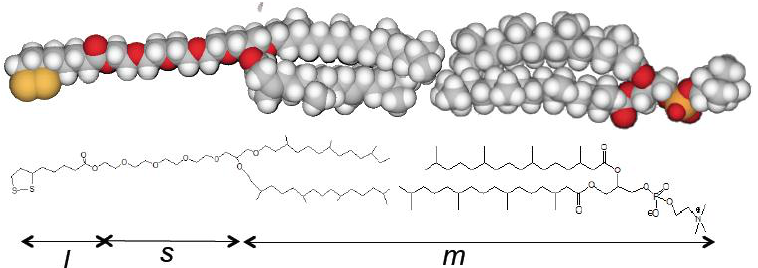
Figure 5. Space filling model and structure of the DPTL thiolipid lipid and of DPhPC, in a tail-to-tail configuration; l , s , and m denote the lipoic acid residue, the tetraethyleneoxy spacer and the hydrocarbon tail region, forming the monomeric unit of a DPTL/DPhPC tethered bilayer lipid membrane. Carbon atoms are in gray, hydrogen atoms in white, oxygen atoms in red, phosphorus atoms in orange and sulfur atoms in yellow.